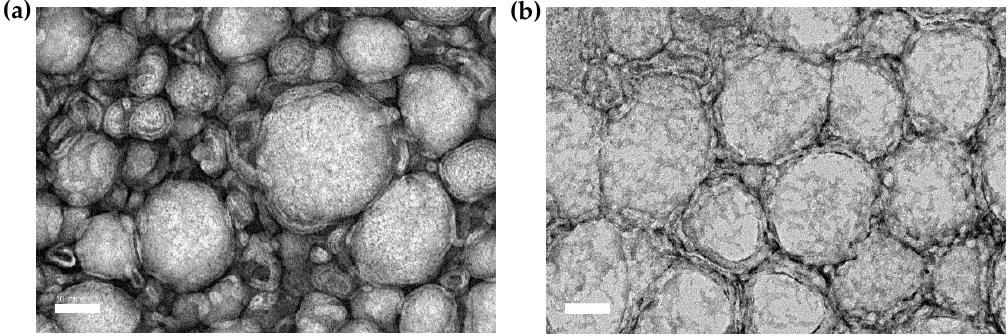
Figure 4. TEM images of ( a ) optimized DTX-loaded nanoemulsion (DNE Opt ) and ( b ) optimized CCM-loaded nanoemulsion (CNE Opt ) stained with uranyl acetate at 28 ± 1 °C. Images were observed under 50,000× magnification with scale bar = 50 nm.